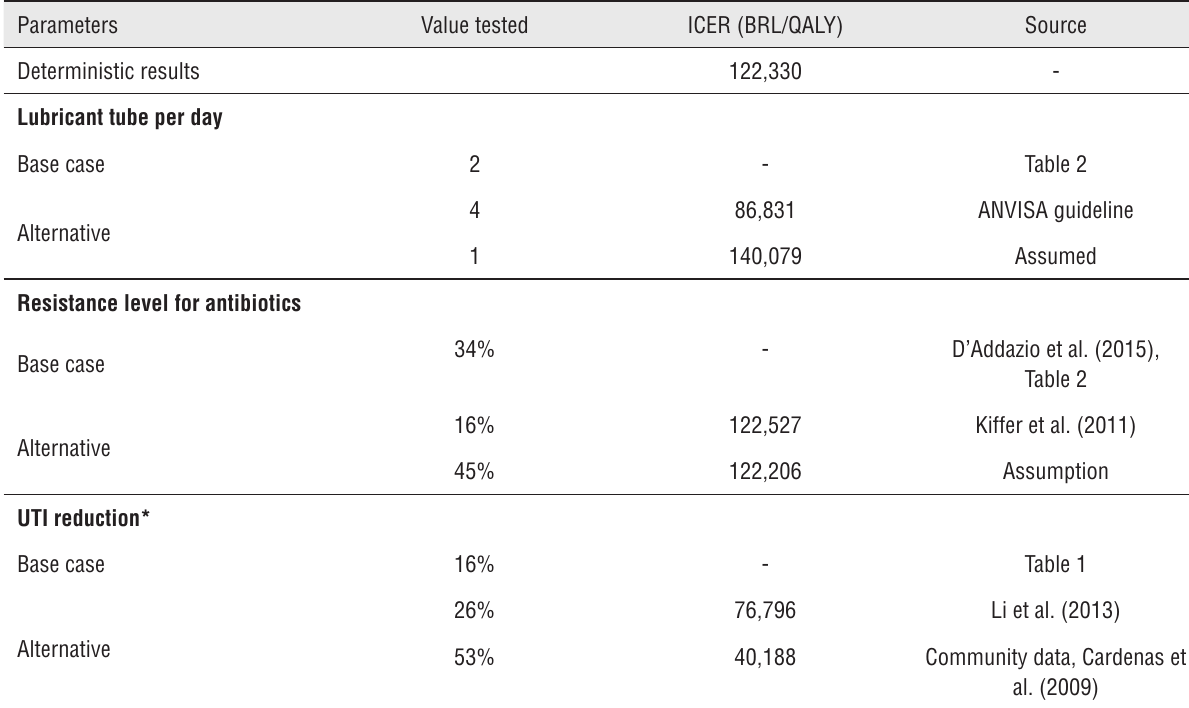
Table 5 - Deterministic univariate sensitivity